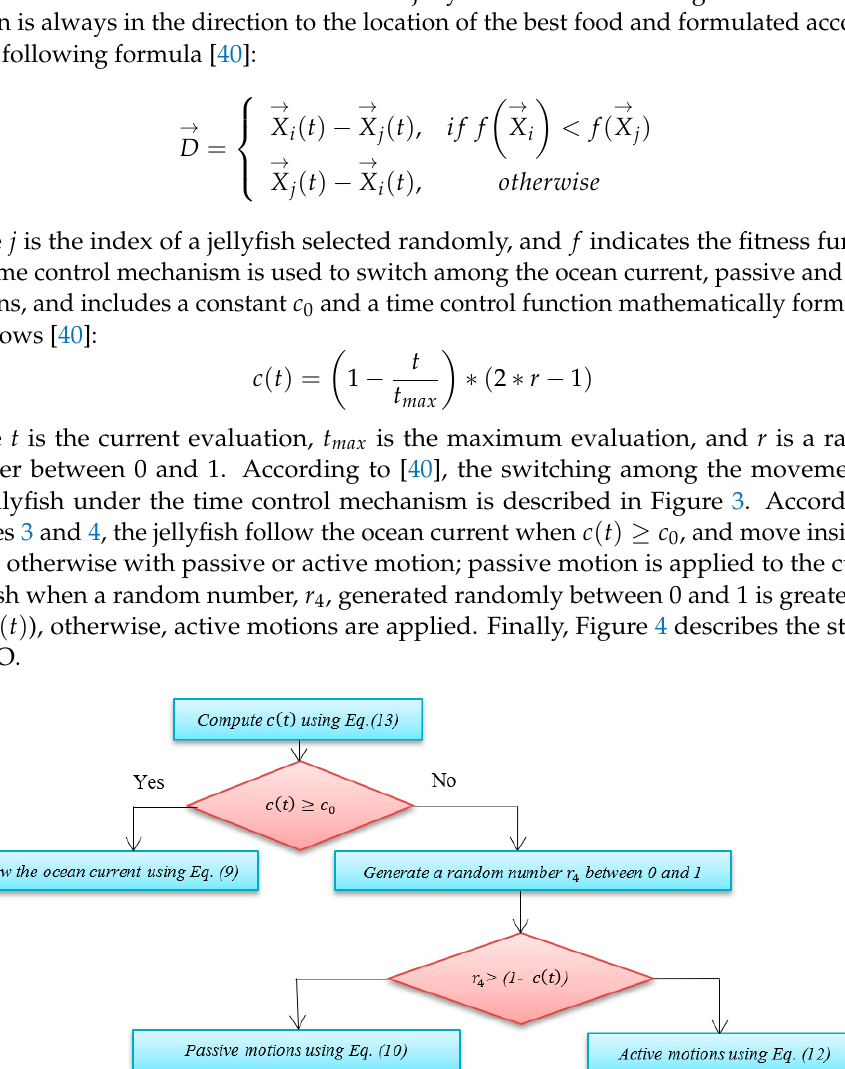
Figure 4. Flowchart of the jellyfish search optimizer (JSO). 4. Proposed Modified JSO (MJSO) Within this section, the JSO is integrated with a novel method to promote exploration and exploitation capabilities when addressing the parameter extraction problem of the PV models based on SDM and DDM. This novel strategy called the PCS is related to a control variable to switch between the exploitation capability of the method to increase convergence toward the best solution and the exploration capability to reduce the likelihood of becoming trapped in local minima. The steps of the proposed algorithm are described in detail within the next subsections.